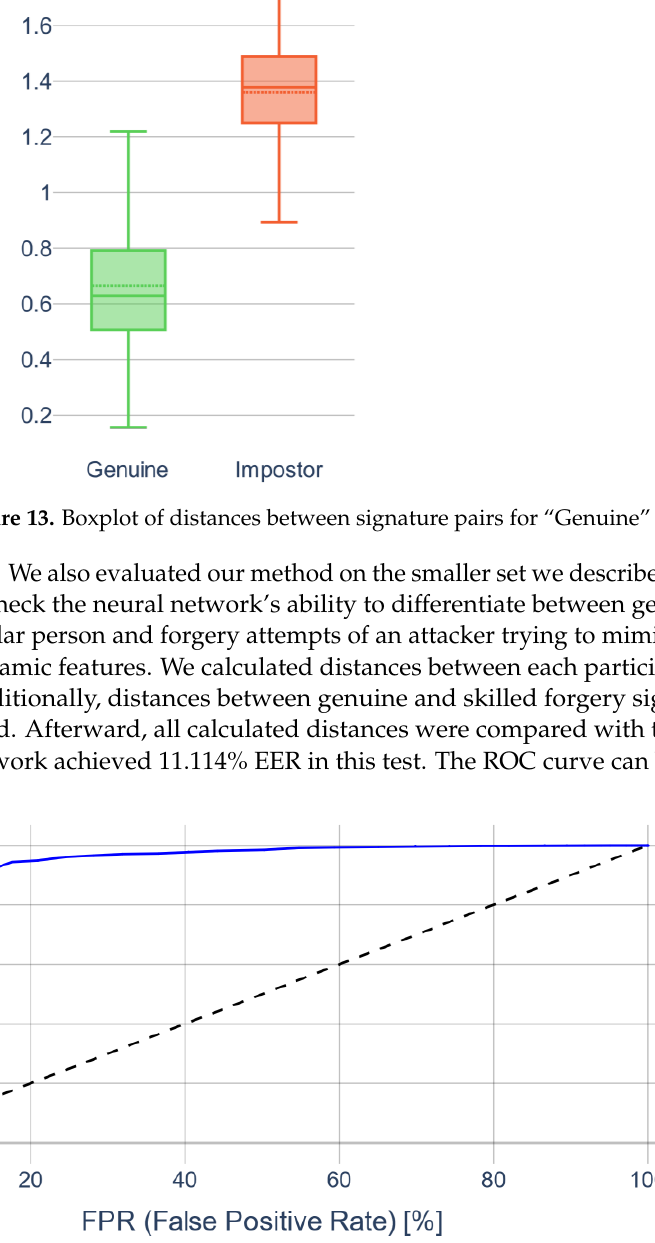
Figure 15. “ Genuine ” histogram shows the distribution of distances for pairs of signatures belonging to a single person. Simultaneously, “ Impostor ” depicts the distance distribution for pairs consisting of one genuine and one forged signature. A boxplot showing the separation between “ Genuine ” and “ Impostor ” scenarios is additionally shown in Figure 16.